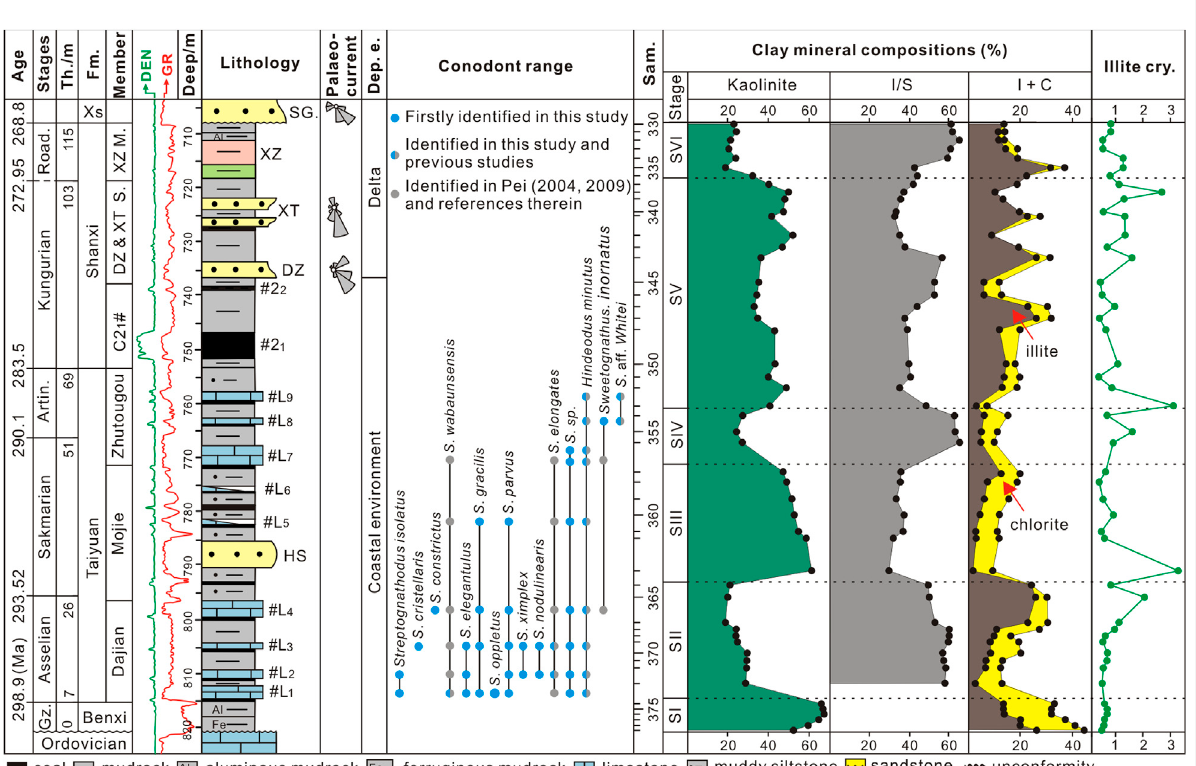
FIGURE 2 Results from conodont biostratigraphic ranges, clay mineral compositions, and illite crystallization from the Yuzhou Coal fi eld. Colors in the lithologycolumnrepresentthoseseeninthe fi eld.Bednumbers#L 1 – L 9 refertoindividuallimestonehorizons(Pei,2004).Paleocurrentdatafromthe Yuzhou Coal fi eld refer to those of (Yang and Lei, 1987), revealing that the paleo fl ow fl owed from north to south in the Shanxi